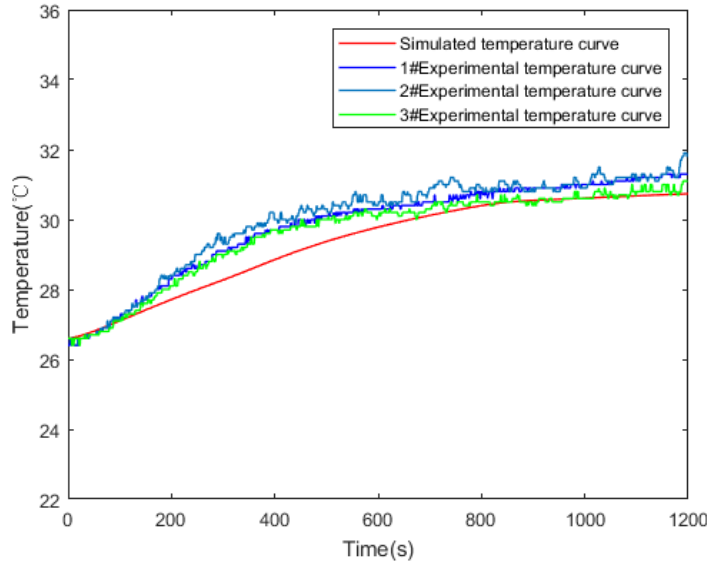
Figure 5. Comparison of simulated and measured temperature curves.